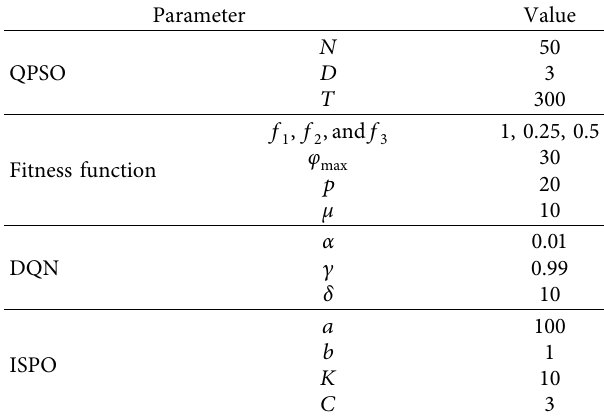
Table 1: Parameter settings in this